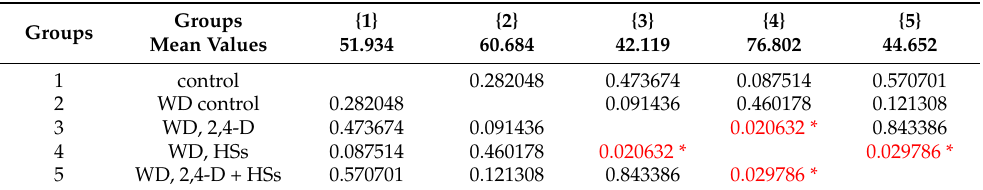
Table 8. ANOVA test for shoot ABA content followed by Duncan test. Values in the cells correspond to p for the difference between the mean values; p ≤ 0.05 is marked with *; p ≤ 0.01—with ** for control plants untreated with either bacteria or HSs and plants grown under water deficit (WD): con- trol, plants treated with Pseudomonas plecoglossicida 2,4-D (2,4-D), humic substances (HSs) and their combinations (2,4-D + HSs).